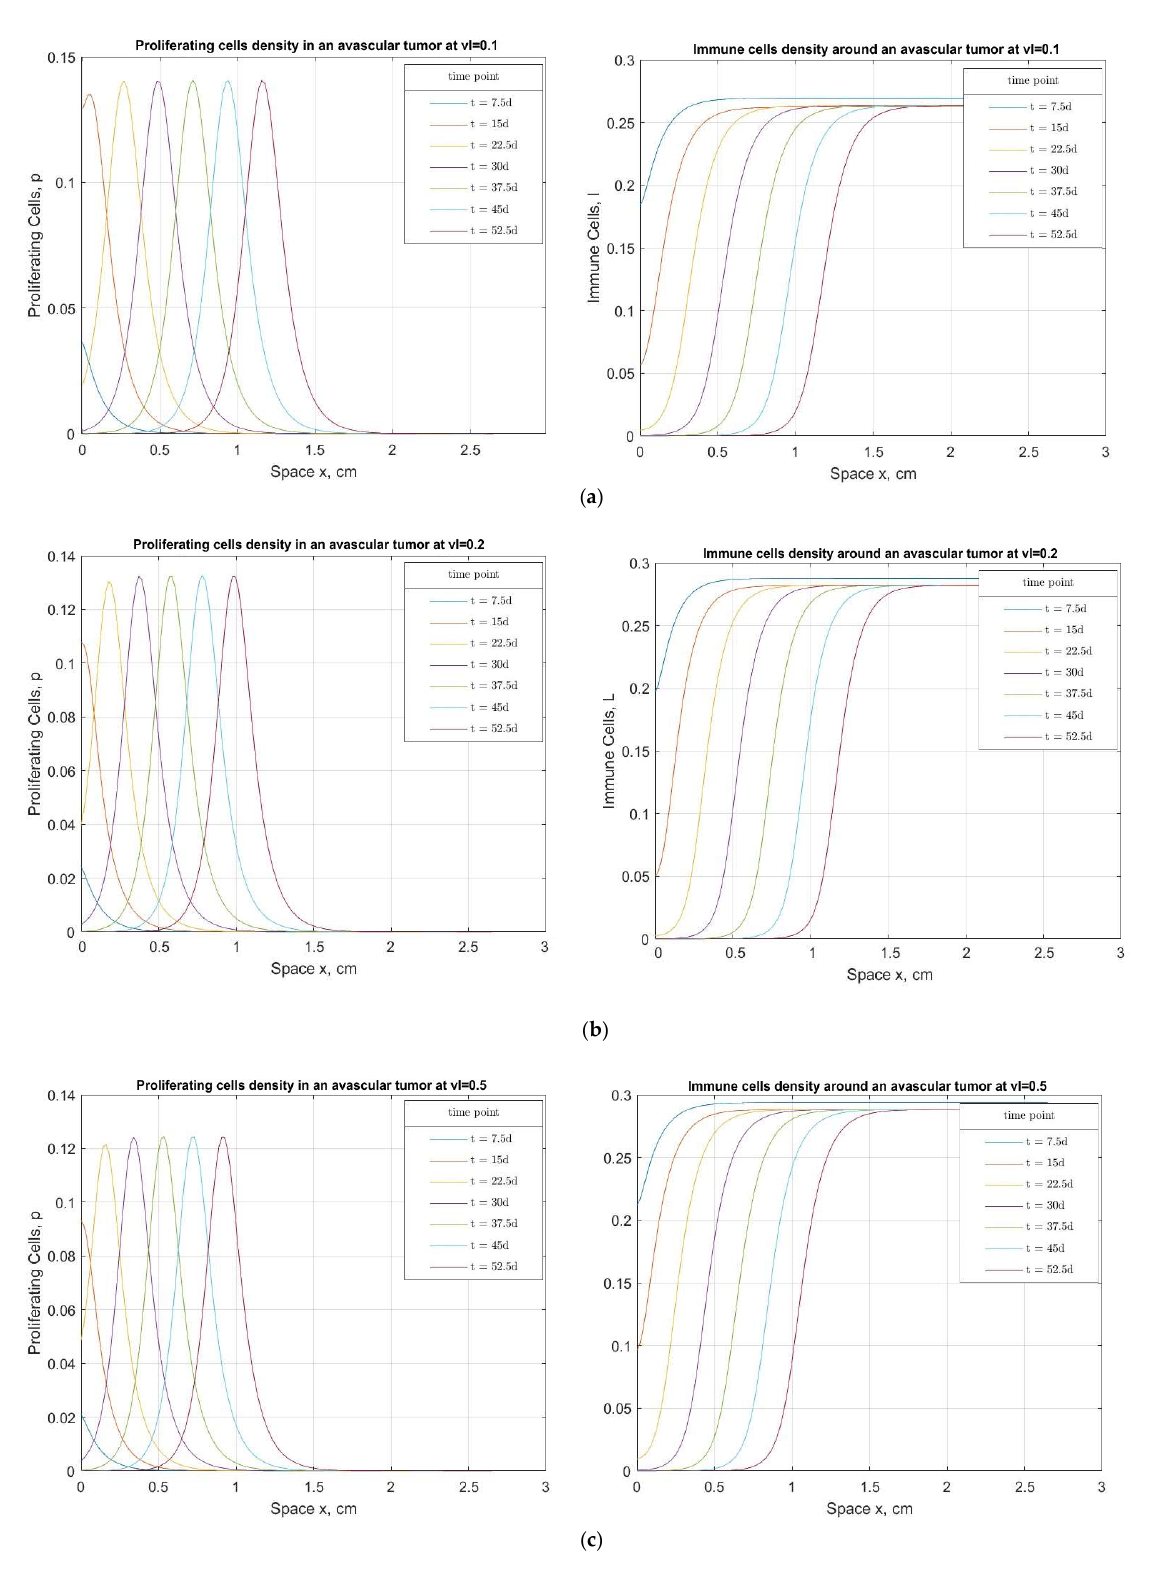
Figure 3. Numerical solutions of proliferating and immune cell densities, for three different levels of immune responses at ( a ) v L 1 = 0.1, ( b ) v L 2 = 0.2, ( c ) v L 3 = 0.5 under the effect of chemotherapy, as functions of space x at times t = 0 . . . 52.5